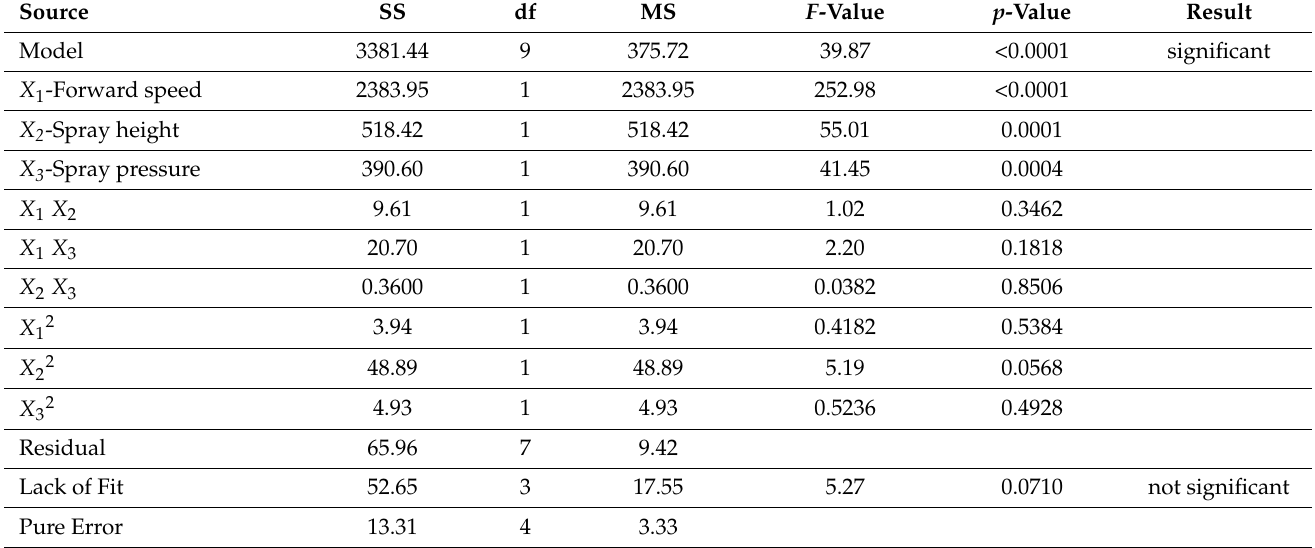
Table 4. ANOVA for droplet